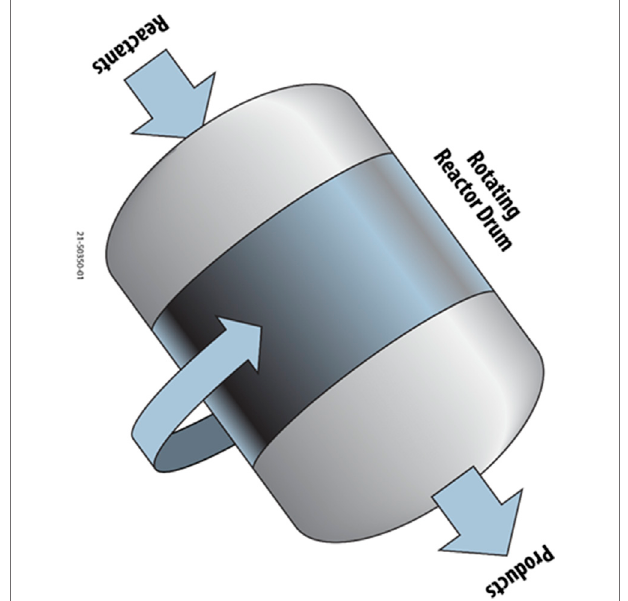
FIGURE 7 | Rotary drum reactor for biomass torrefaction.